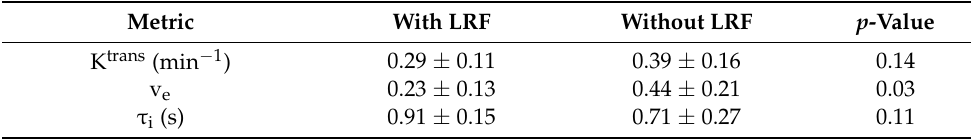
Figure 4. Bar plot comparing the mean value of ( A ) volume transfer constant (K trans ), ( B ) extravas- cular extracellular space volume fraction (v e ), and ( C ) mean lifetime of intracellular water protons ( τ i ) from fast exchange regime model between patients with and without locoregional failure (LRF) of nasopharyngeal carcinoma. The metric v e exhibited a significant difference between patients with and without LRF. K trans and τ i showed little significance ( p = 0.14 for K trans and p = 0.11 for τ i ).